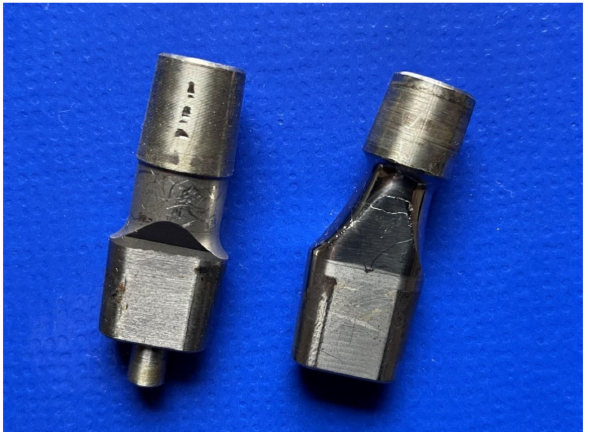
Figure 2. The interchangeable neck of the GSP (Cremascoli S.p.A.) ( left ) and Profemur Z (Wright Medical Technology Inc.) ( right ) dual modular hip implants. Both necks are short, the GSP-neck is straight, and the Profemur Z-neck is in an 8 ◦ varus orientation. The GSP neck was explanted 22 years after primary THA because of a late haematogenous infection, and the Profemur Z-neck was explanted 14 years after primary THA due to aseptic loosening. Note the same dimensions of the oval-shaped distal Morse